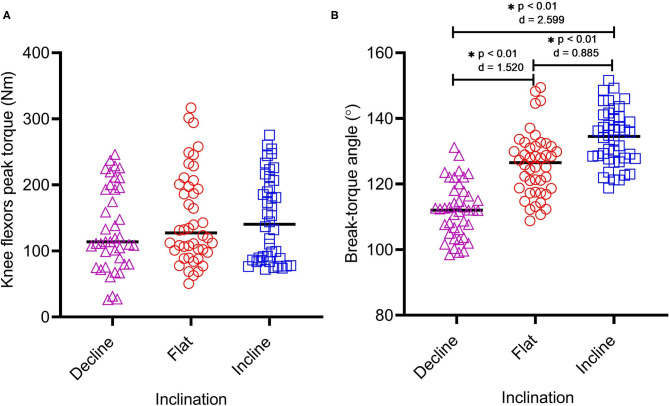
Eccentric knee flexor peak torque (A) and break-torque angle (B) at each inclination (DEC n = 41, FLAT n = 44, and INC n = 42) whilst performing the Nordic hamstring exercise on the HALHAM°. Asterisks (*) indicate any significant differences between inclination.